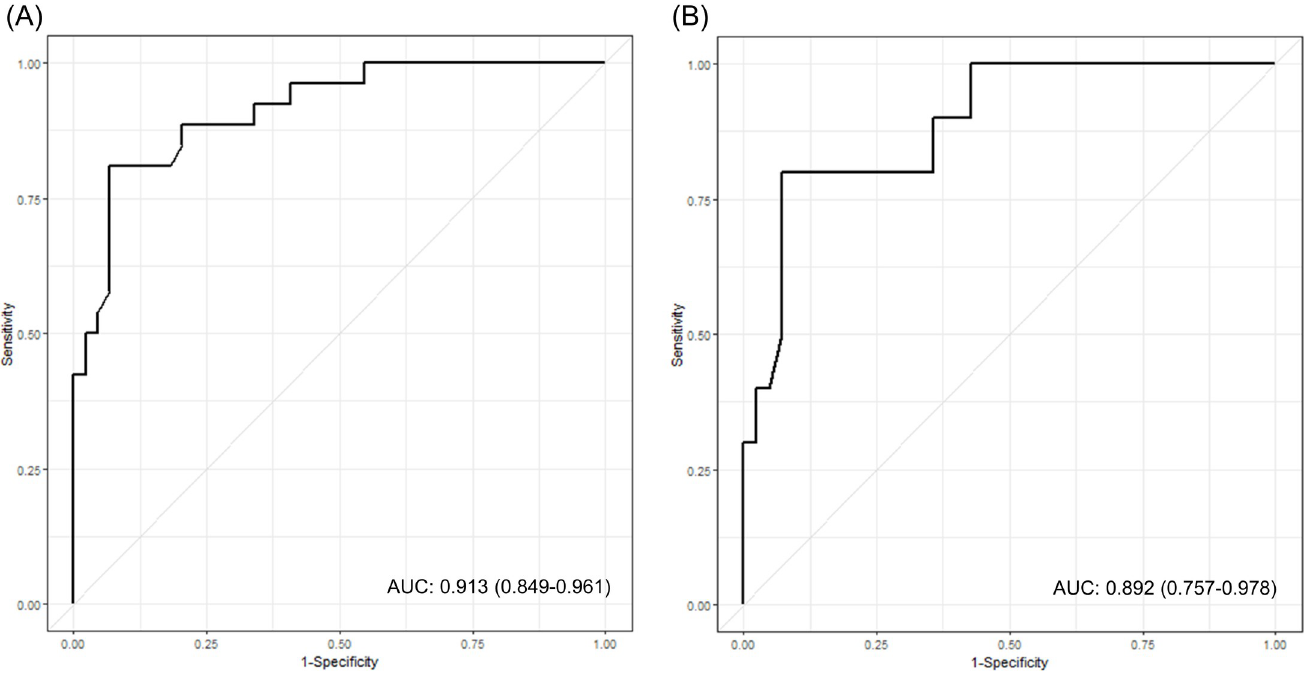
Fig 2. Receiver operating characteristic (ROC) curve for serum neuron-specific enolase (NSE) level and poor neurological outcome following near-hanging injury. (A) Predictive performance of NSE for the total patient population (AUC, 0.905; 95% CI, 0.841–0.958). (B) Predictive performance of NSE for patients with cardiac arrest (AUC, 0.892; 95% CI, 0.757–0.978). AUC, area under the curve; CI, confidence